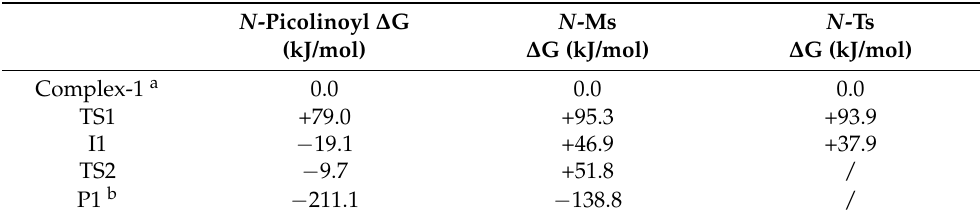
Table 2. Free energy for the variously N-protected non-substituted aziridine using the model in Figure 1 (see below).